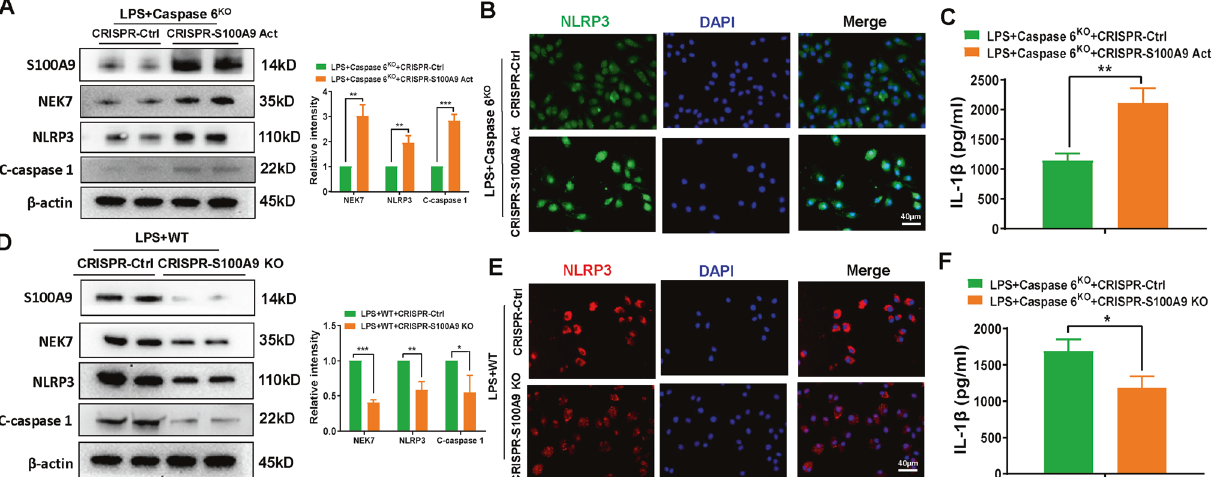
Fig. 7 S100A9 is essential for NLRP3 activation and pyroptosis in Caspase 6-mediated in fl ammation induced by IR in fatty liver. BMMs from WT or Caspase 6 KO mice were transfected with the CRISPR-S100A9 Act, CRISPR-S100A9 KO or control vector followed by LPS stimulation; ( A , D ) Western blotting and relative intensity of S100A9, NEK7, NLRP3 and C-caspase 1 in LPS-stimulated BMMs; ( B , E ) IF staining for NLRP3 expression in macrophages. DAPI was used to visualize nuclei. Scale bar: 40 μ m; ( C , F ) ELISA analysis of IL-1 β levels in culture medium. N = 4 – 7/ group, all data represent the mean ± SD, * p < 0.05, ** p < 0.01, *** p <